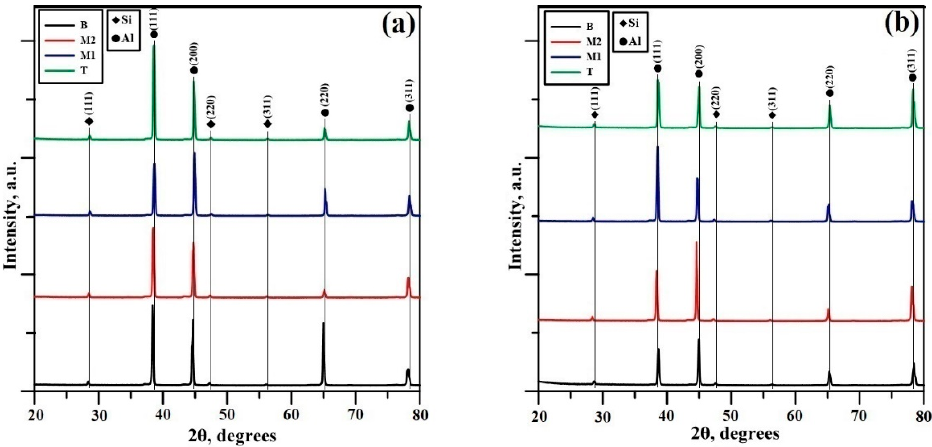
Figure 3. X-ray diffraction results at the different stages of growth of the specimens build-up at a welding speed of: ( a ) 13.3 mm/s; ( b ) 20.0 mm/s.